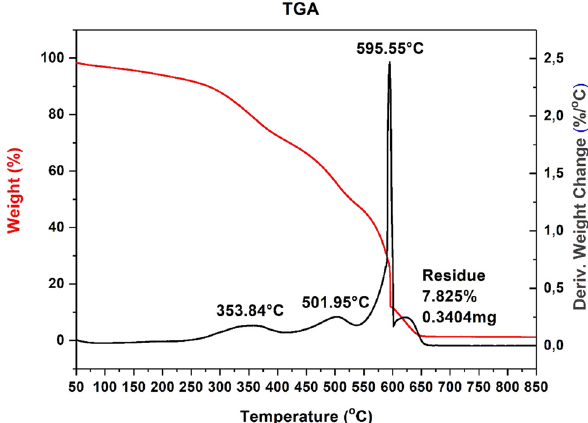
Figure 12: TGA thermogram for modi fi ed CNTs after acylation with 5 ( 6 )- carboxy fl